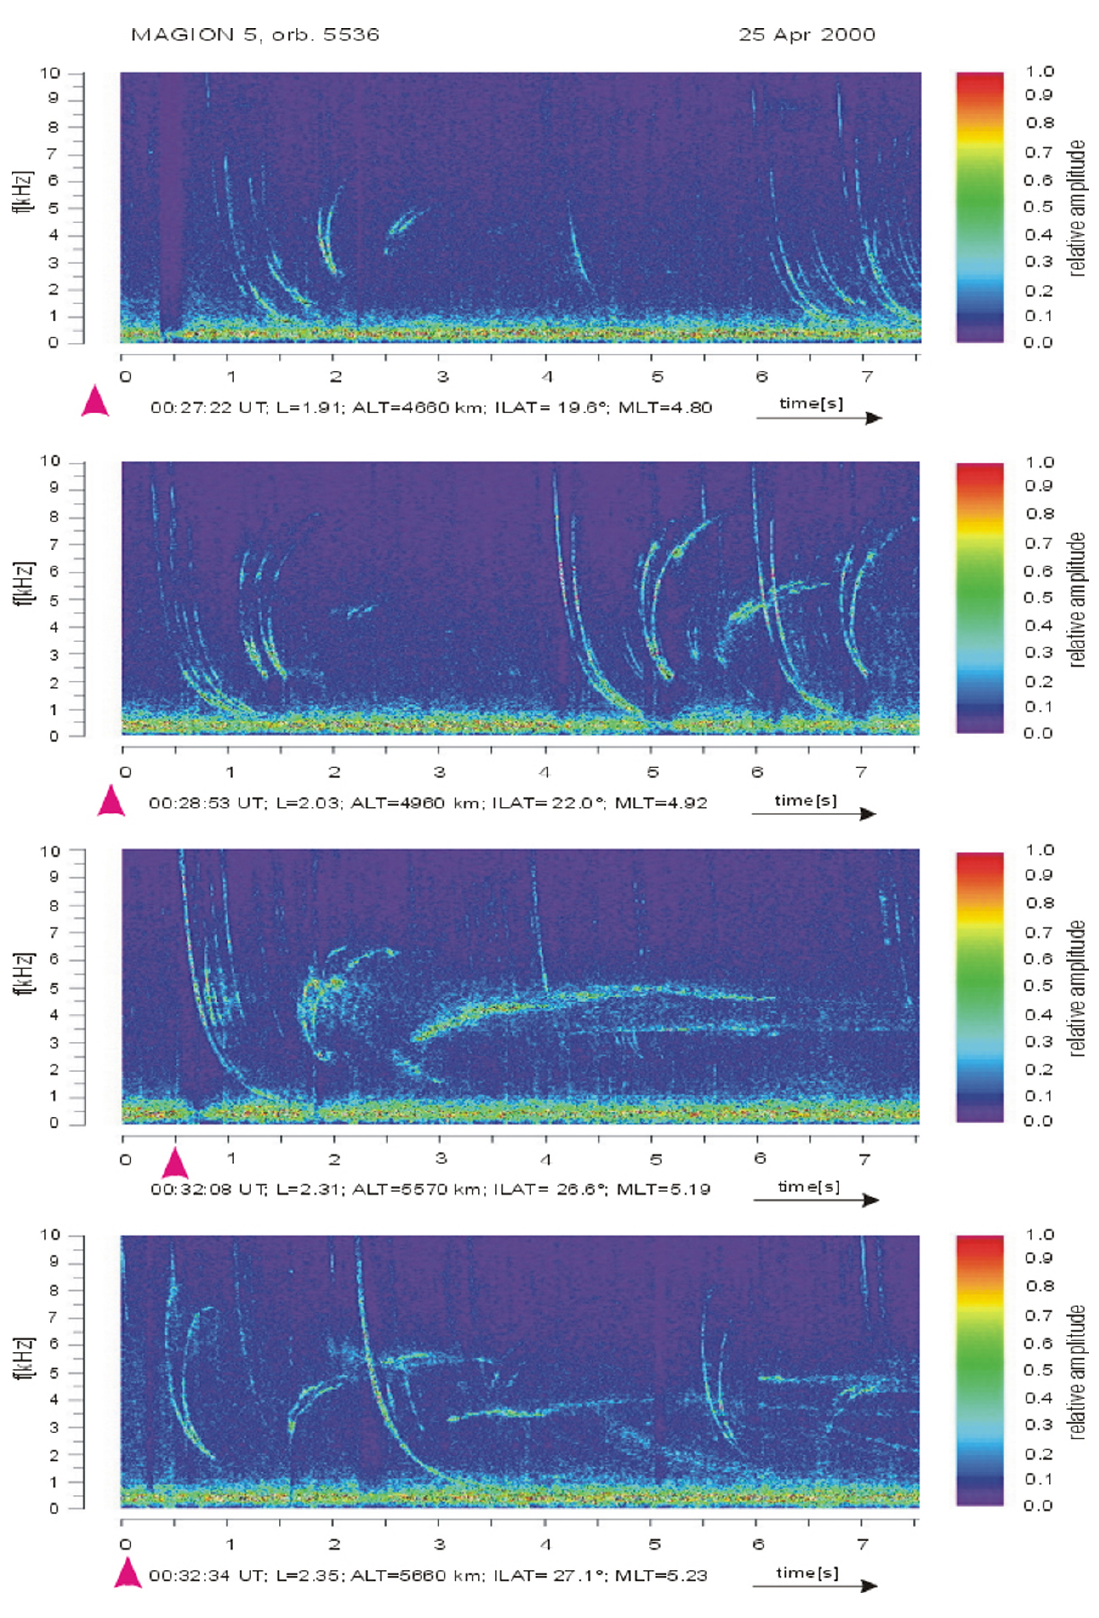
Fig. 9. Series of spectrograms observed by MAGION 5 on orbit 5536 far from the